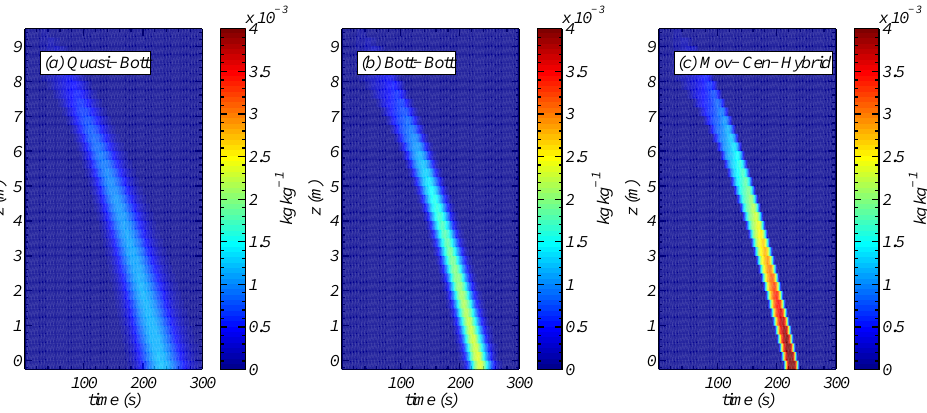
Fig. 3. As Fig. 2, but for ice mass. It can be seen that the peak in mass is significantly affected in the single moment model runs (a) and (b) compared to the double moment scheme (c) .